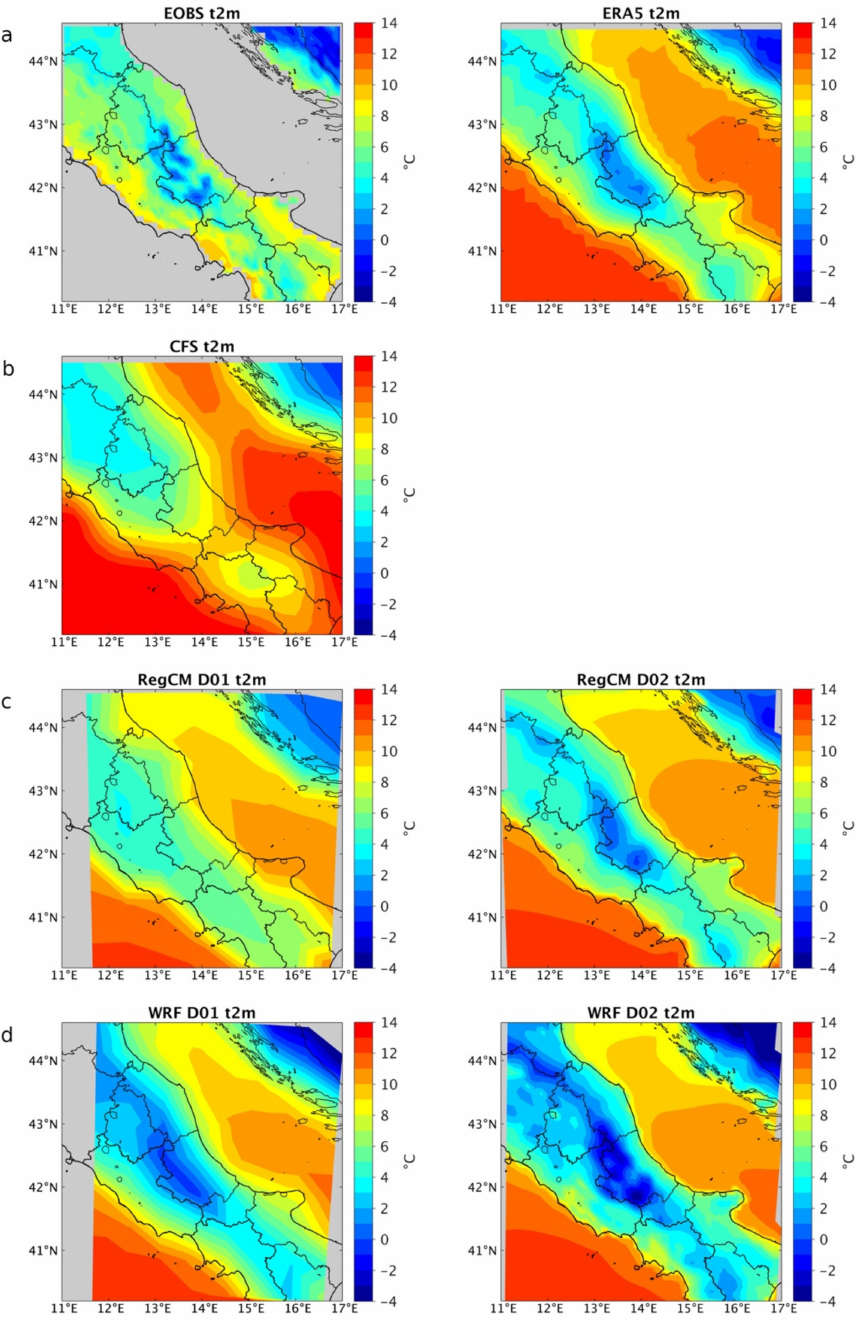
Figure 3. Comparison of the climatologically averaged daily temperature over the reference period for ( a ) reference products EOBS and ECMWF ERA5. ( b ) Global-scale CFS. ( c ) RegCM D01 and D02 and ( d ) WRF D01 and